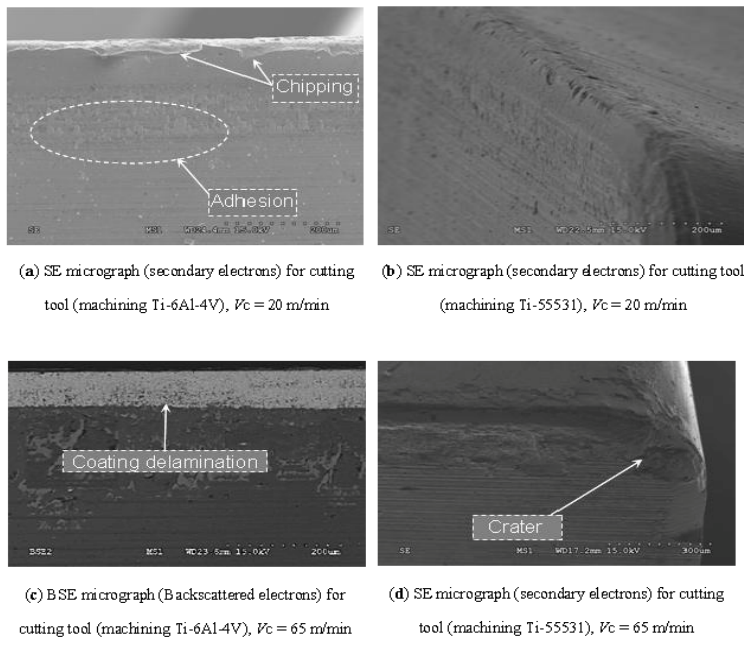
Figure 16. SEM images (BSE and SE micrographs) of the tool wear when